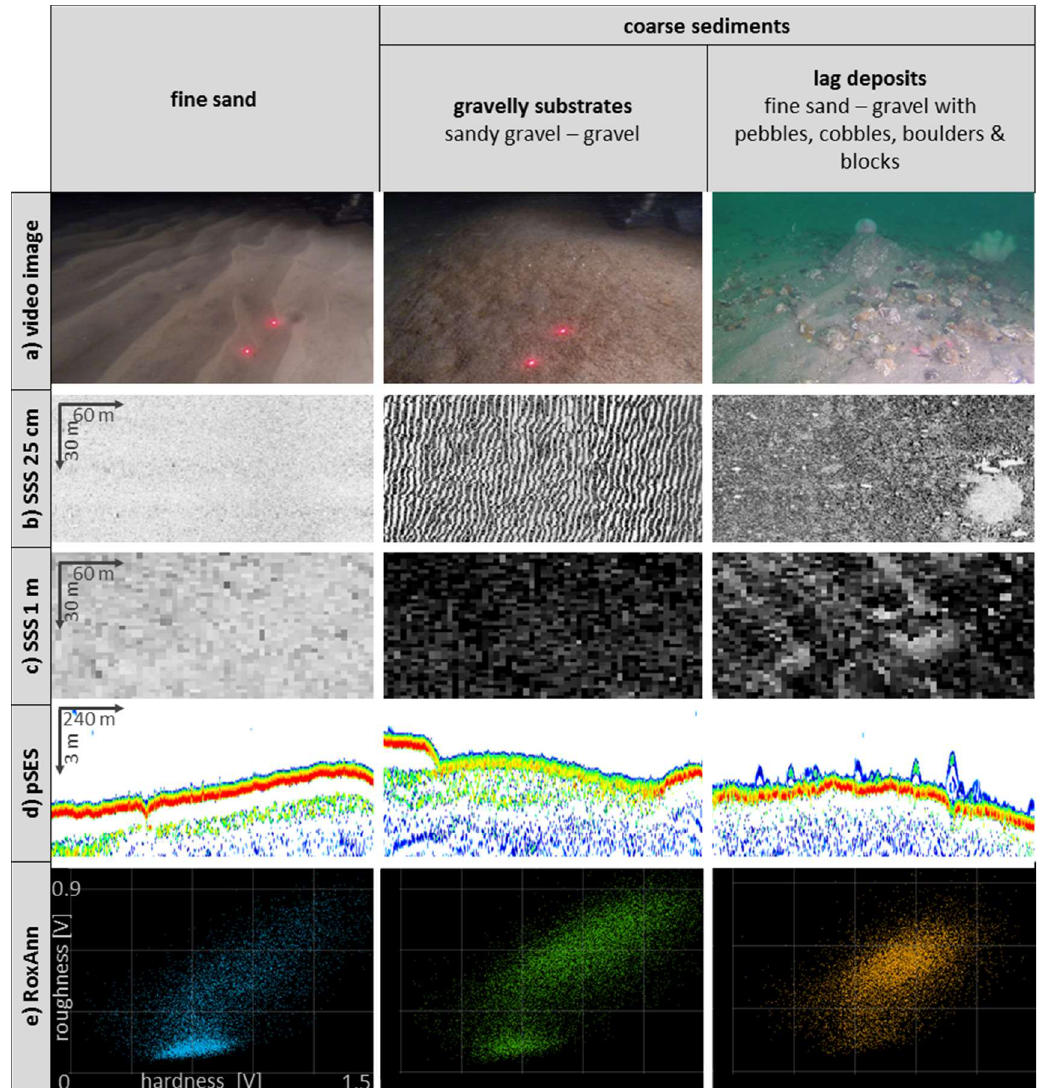
Figure 3. Main sediment types found in the study area: fine sand, gravelly substrate, lag deposits. For each class, the following supplementary information is provided exemplary: ( a ) underwater video image (the red laser dots have a spacing of 10 cm), ( b ) sidescan sonar (SSS) backscatter image in high (25 cm) and ( c ) low (1 m) resolution, ( d ) a pSES and ( e ) the RoxAnn scatter plot.